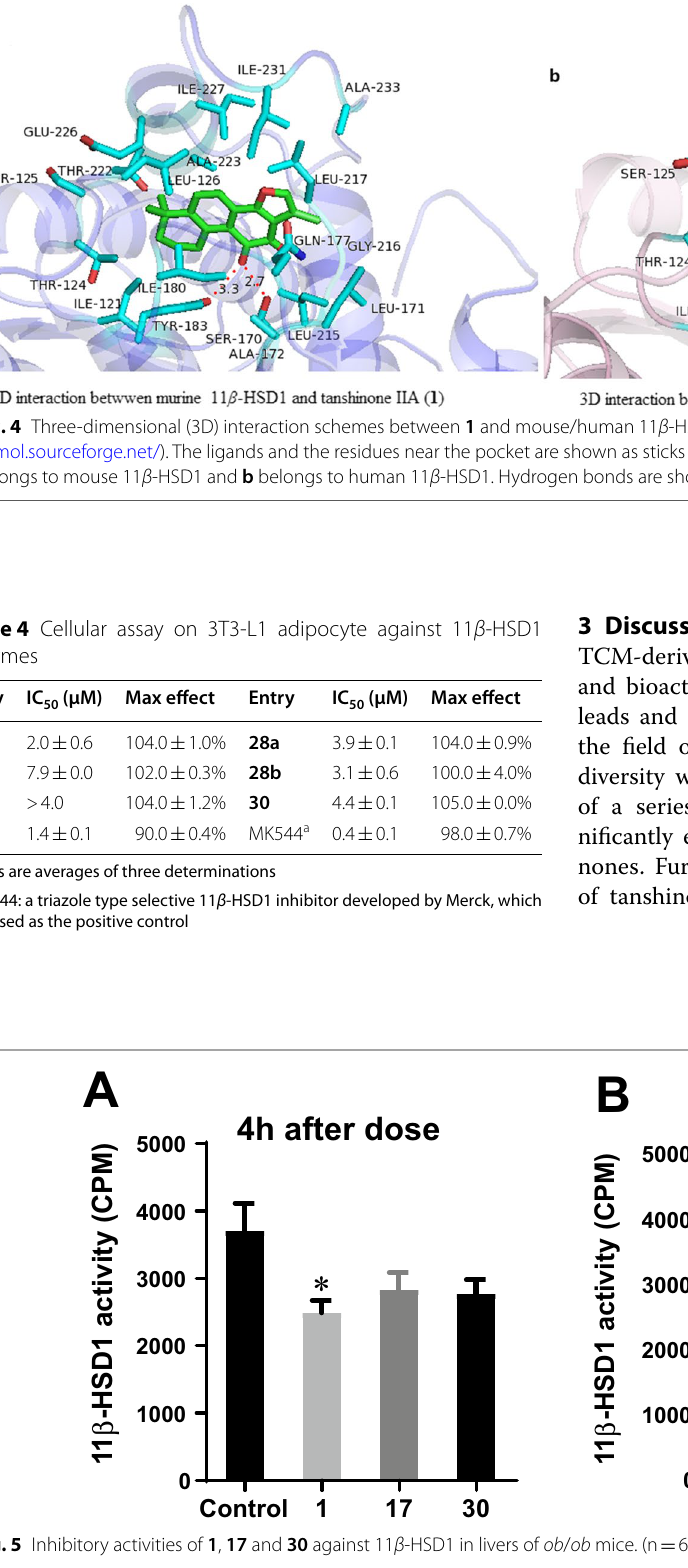
6, Mean SE, * P < 0.05, ** P < 0.01 vs = ±